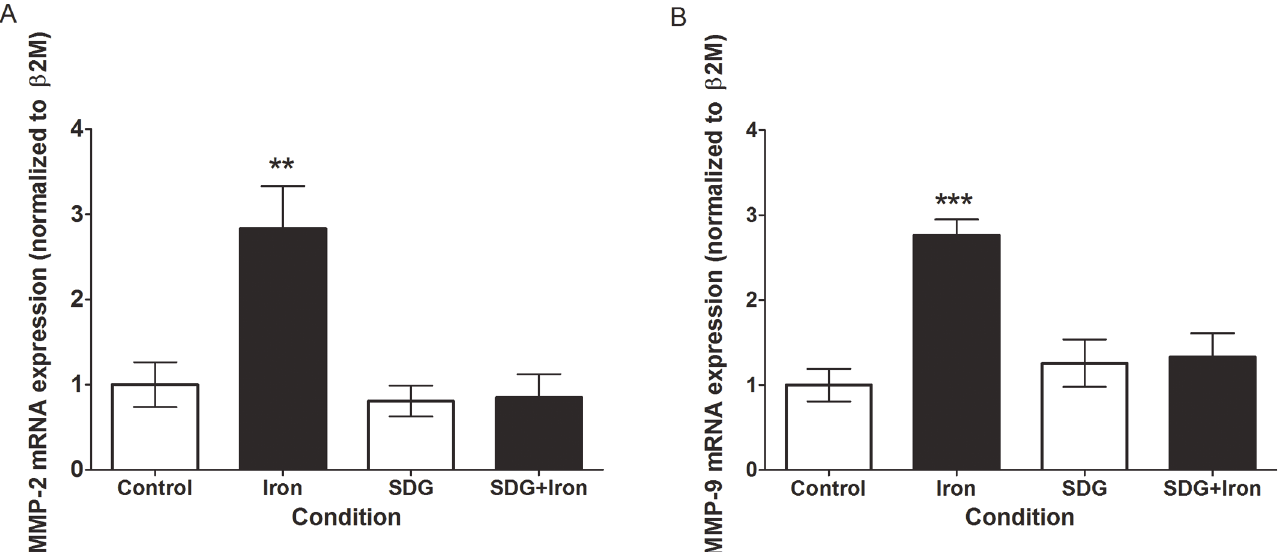
Fig 5. SDG decreases iron-induced MMP gene expression in H9c2 cells. Gene expression of matrix metalloproteinases in control, 50 μ M iron-treated, 500 μ M secoisolariciresinol diglucoside (SDG), and SDG pre-treatment + iron-treated H9c2 cells. mRNA levels of matrix metalloproteinase (MMP)-2 (A) and MMP-9 (B) were determined via quantitative real-time PCR and normalized to β 2-microglobulin, with normal expression standardized to the control. ( *** = p < 0.001 versus control; ** = p < 0.01 versus control, n = 3).